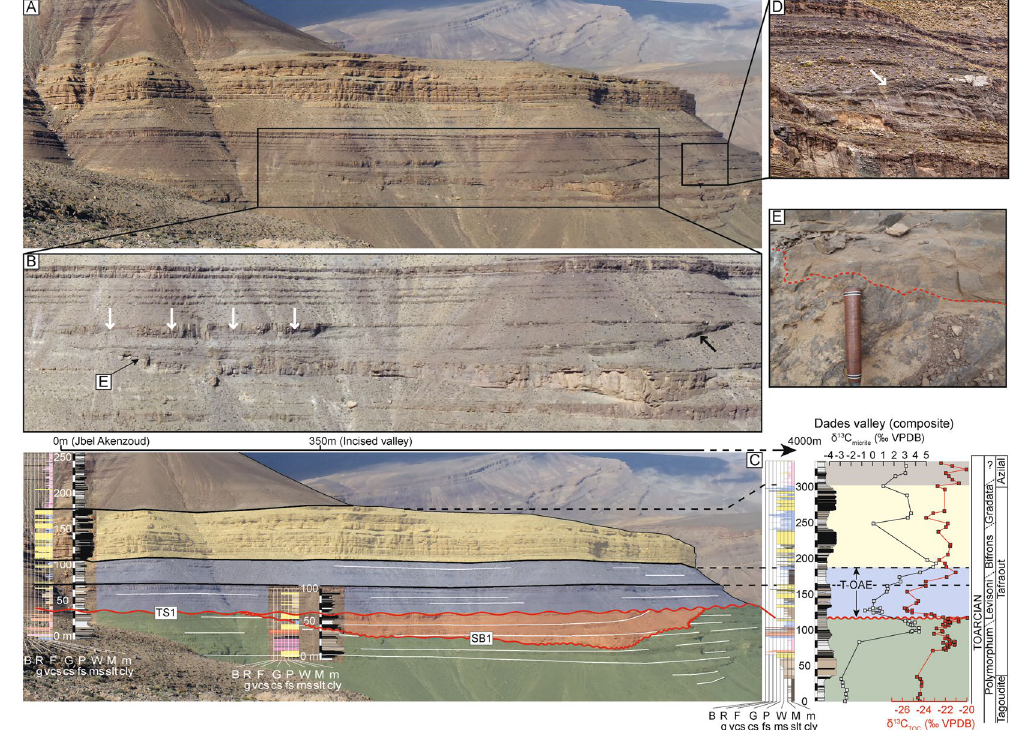
Figure 2. ( A ) General aspect of the outcrop from Jebel Akenzoud (Dades Valley, Central High Atlas Basin, Morocco). The two rectangles indicate zoom in on selected portions of the outcrop. ( B ) Close-up view of the left-hand side of the panel. Lateral accretion within the ooidal shoal in the uppermost part of the infilling unit can be seen (white arrows). The black arrow points at the right edge of an inferred tidal channel within the uppermost infilling unit. ( C ) Stratigraphic correlation of sections TS1 and SB1 (this study) with Dades Valley composite 13 . From the bottom to the top, the green unit = lower host unit; orange unit = median infilling unit; blue unit = upper sealing unit, stratigraphically correlative to the T-OAE; yellow unit = rest of the sealing unit. Note that the 50 m incision affects the uppermost part of the Polymorphum Zone and is directly overlain by sedimentary rocks belonging to the T-OAE stratigraphic interval. ( D ) Close up view on the right-hand side shoulder of the infilling unit. The presence of a wedge-shaped sedimentary body (white arrow) hints at multiple sub-episodes of erosion and deposition during the infill of this unit. ( E ) Close up on the erosion surface affecting the lower host unit